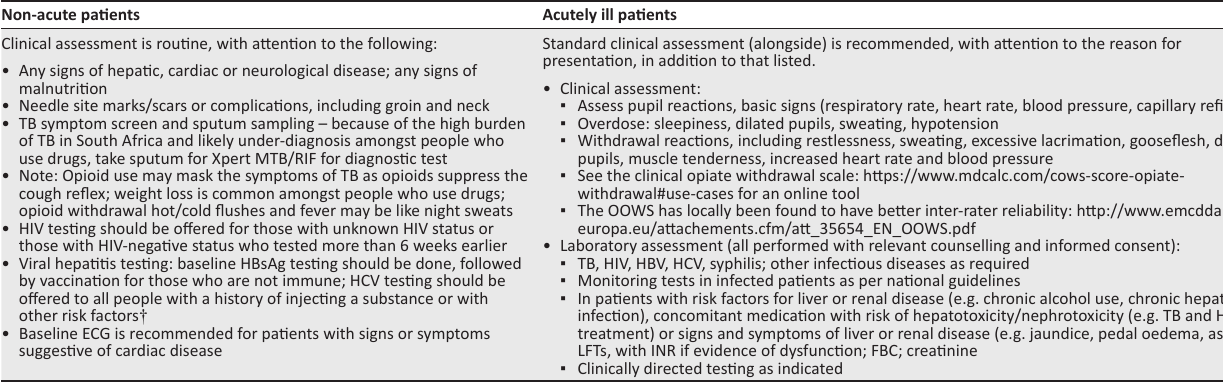
TABLE 3-A3: Clinical assessment – differs, based on whether or not the patient is acutely ill. 81 Non-acute